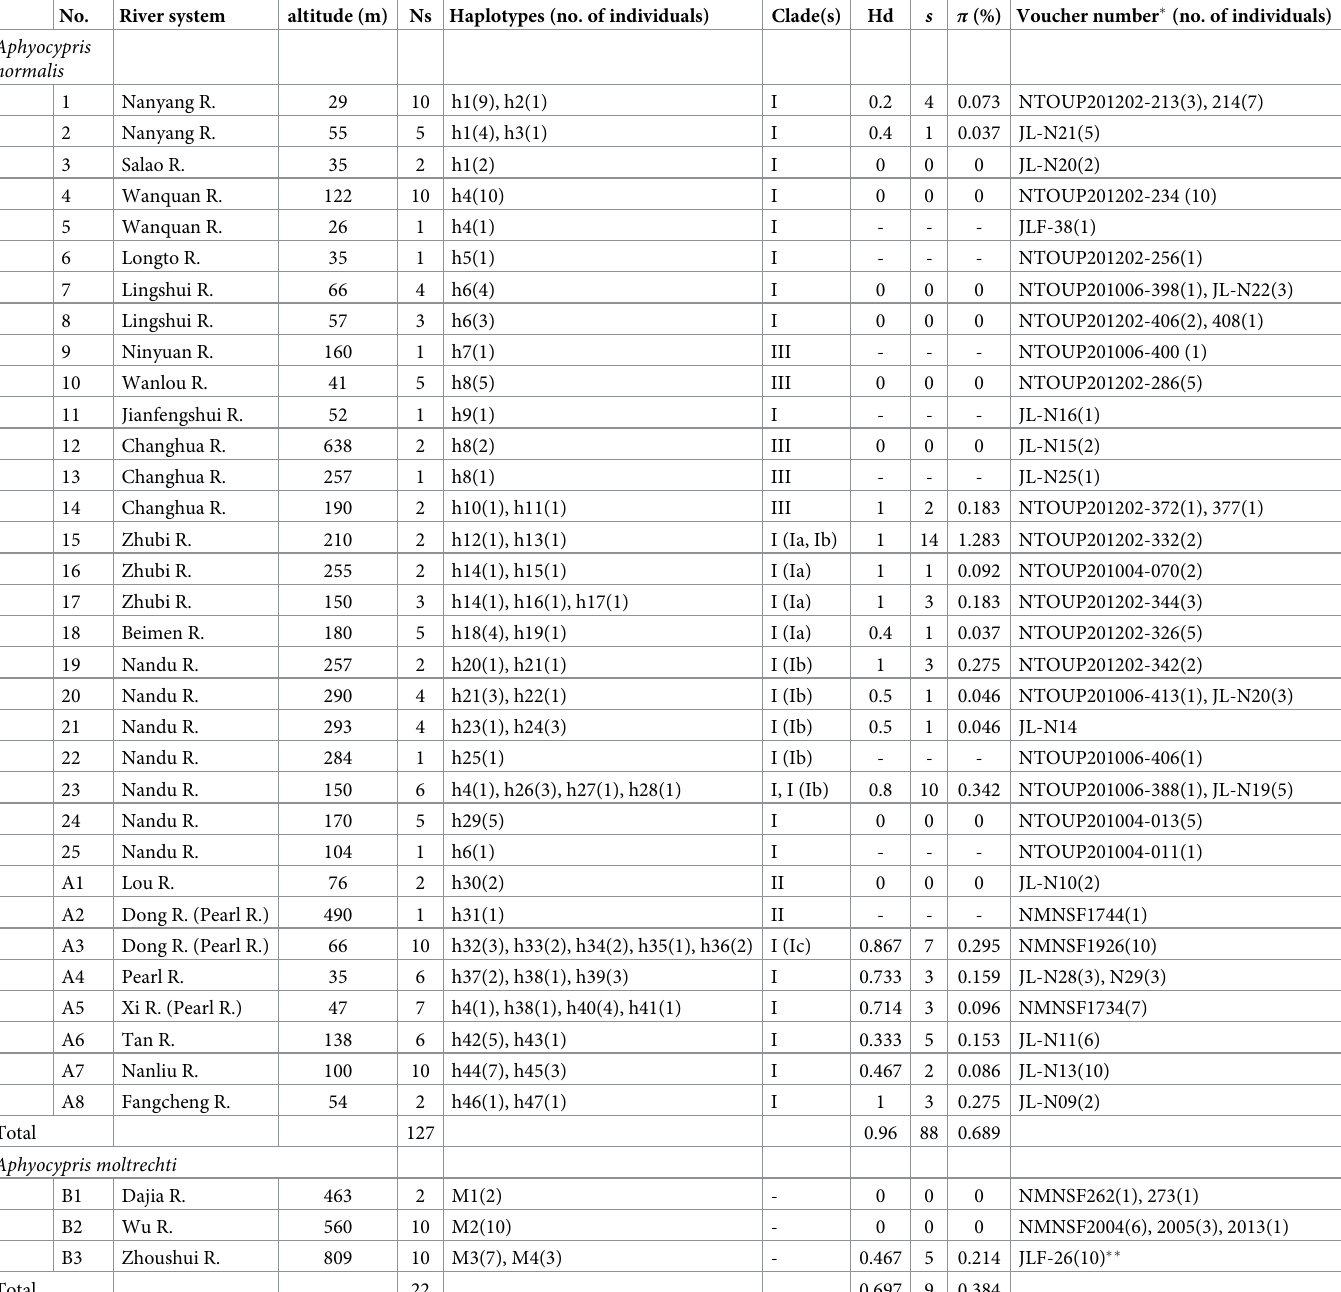
Table 1. Sample locations and haplotype distributions of Aphyocypris samples used in this study. No. River system altitude (m) Ns Haplotypes (no. of individuals) Clade(s) Hd s π (%) Voucher number � (no. of